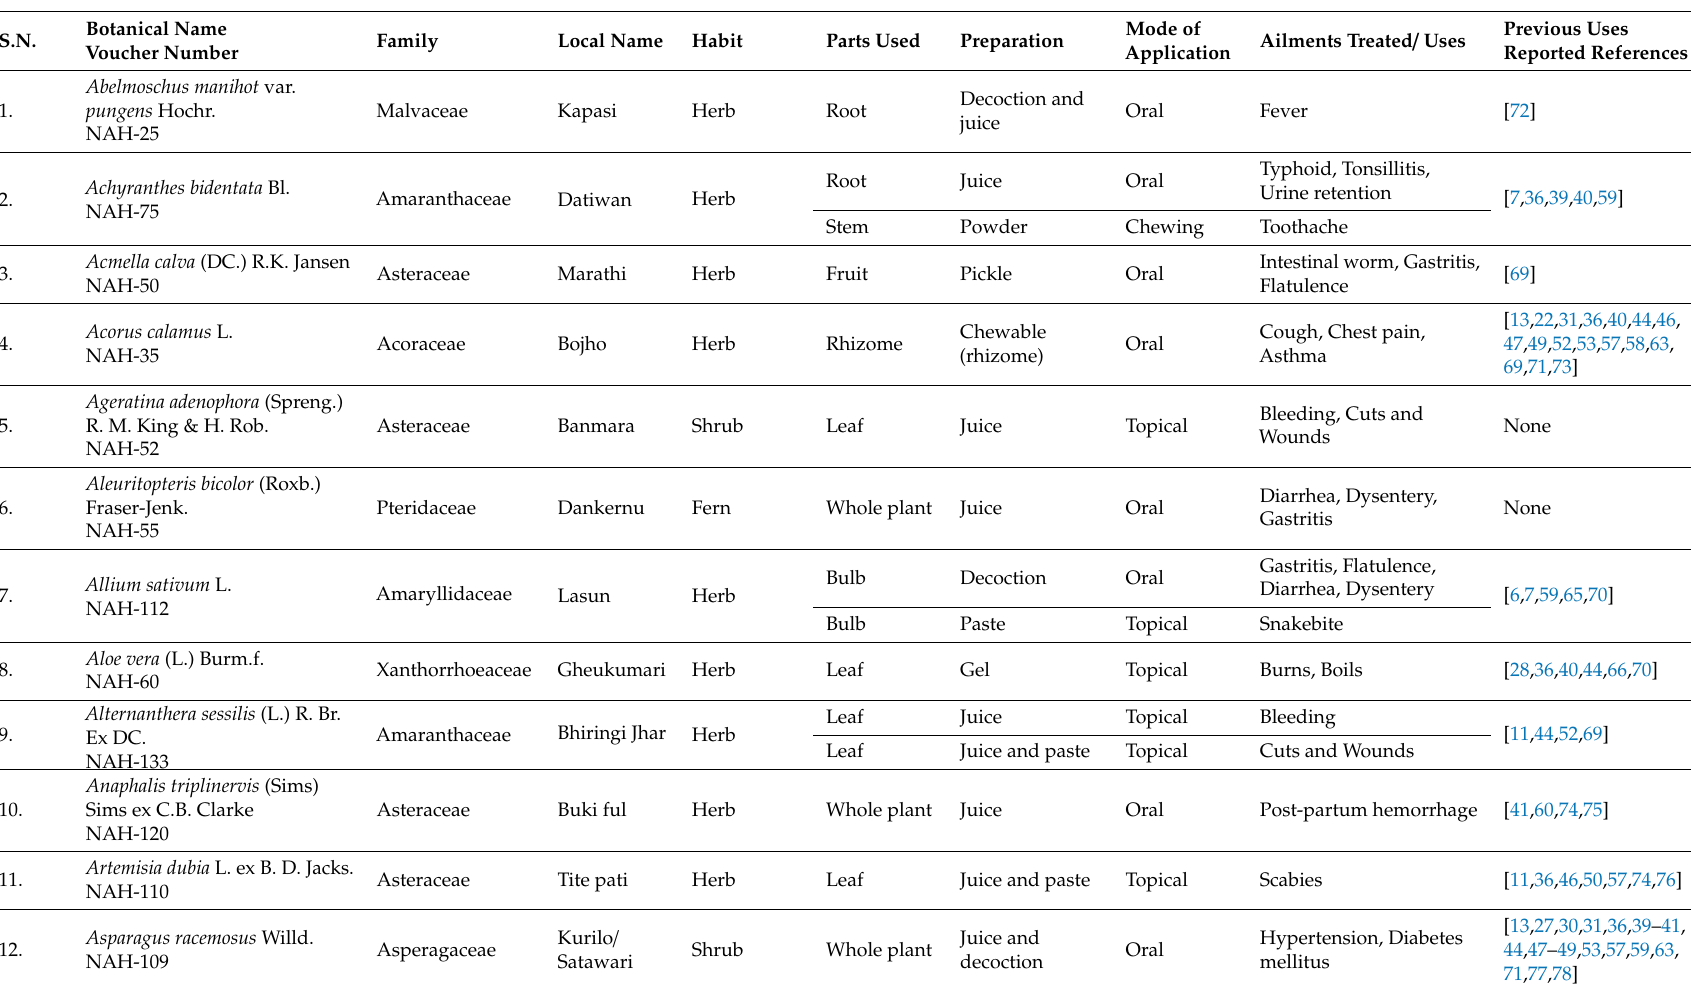
Table 1. Enumeration of medicinal plant species used with their parts used, preparation form, local names, family names, mode of application and ailments treated.